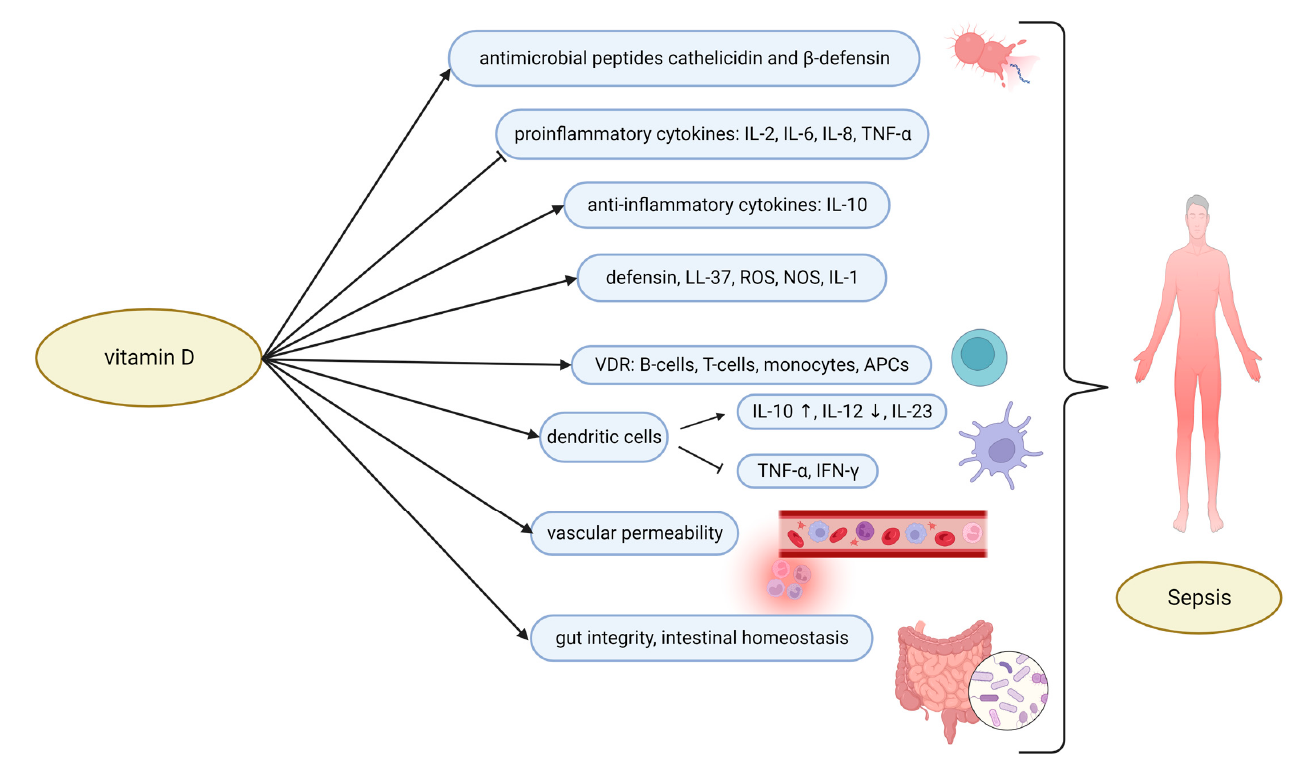
Figure 2. Overview of vitamin-D-mediated pathways in sepsis patients. Vitamin D exerts its immunomodulatory effects, e.g., through the production of antimicrobial peptide, the inhibition of proinflammatory cytokines, and the stimulation of anti-inflammatory cytokines. 1,25(OH) 2 D can prevent dendritic cells from maturing and differentiating by interacting with VDR. Vitamin D may have additional benefits in sepsis, such as effects on endothelial function, coagulation, and hemodynamic stability. Abbreviations: 1,25(OH) 2 D, 1,25-dihydroxyvitamin D; IL, interleukin; TNF- α , tumor necrosis factor-alpha; ROS, reactive oxygen species; NOS, nitric oxide synthase; VDR, vitamin D receptor; APCs, antigen-presenting cells; IFN- γ , interferon gamma.